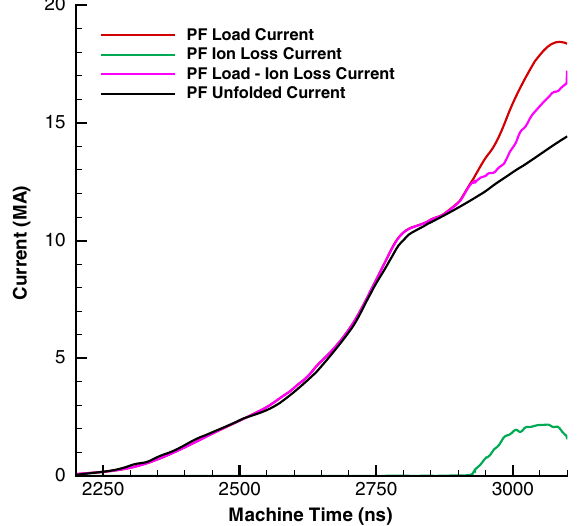
FIG. 6. Ion loss current (green), Z circuit model load current prediction (red), and the velocimetry-based load current unfold (black) compared to the circuit model prediction less the ion loss current (pink). Though the ion loss does not completely account for the estimated load current, it does indicate that catastrophic loss could be qualitatively predicted.